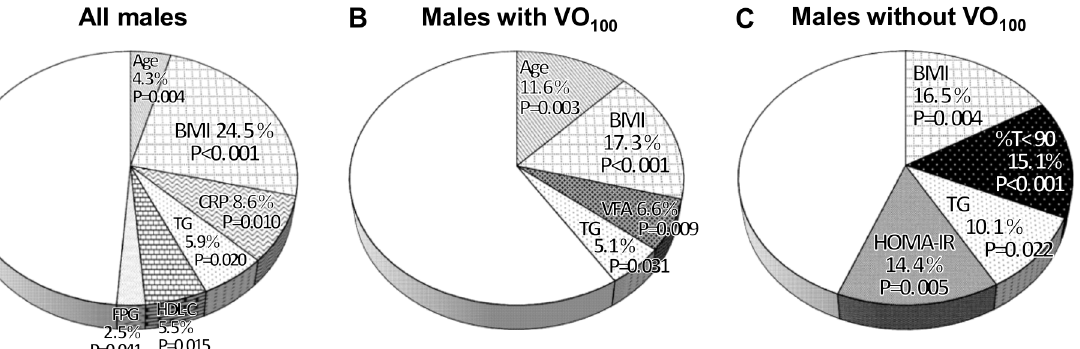
Fig 2. Coefficients of determination (R 2 ) in stepwise multiple regression models for CT LFA in all males and males stratified according to VO 100 . (A) All males, (B) males with VO 100 , and (C) males without VO 100 . Variables entered into the stepwise regression analyses were selected from age, BMI, neck circumference, waist circumference, systolic and diastolic blood pressures, alcohol intake, use of lipid-lowering agents, current smoking, VFA, SFA, AHI, 4% ODI, %T < 90, lowest SpO 2 , arousal index, REM sleep, AHI during REM, supine sleep time, AHI in supine position, Epworth sleepiness scale score, CRP, triglycerides (TG), HDL-cholesterol (HDL-C), LDL-cholesterol, fasting plasma glucose (FPG), and HOMA-IR when yielding a P-value < 0.10 by univariate